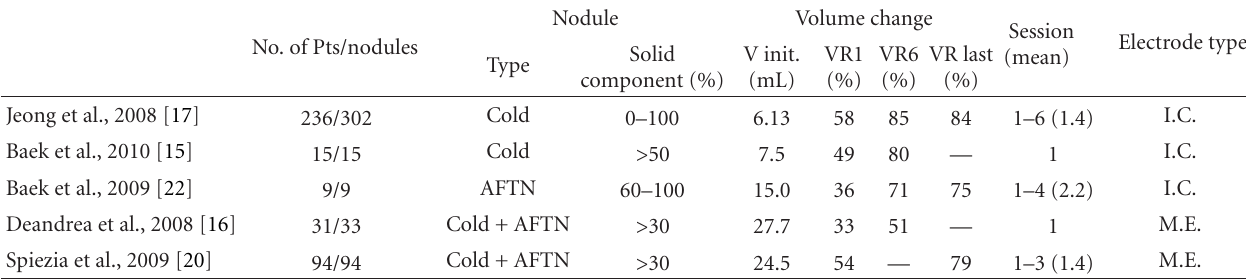
Table 1: Characteristics and treatment results of radiofrequency ablation for benign thyroid